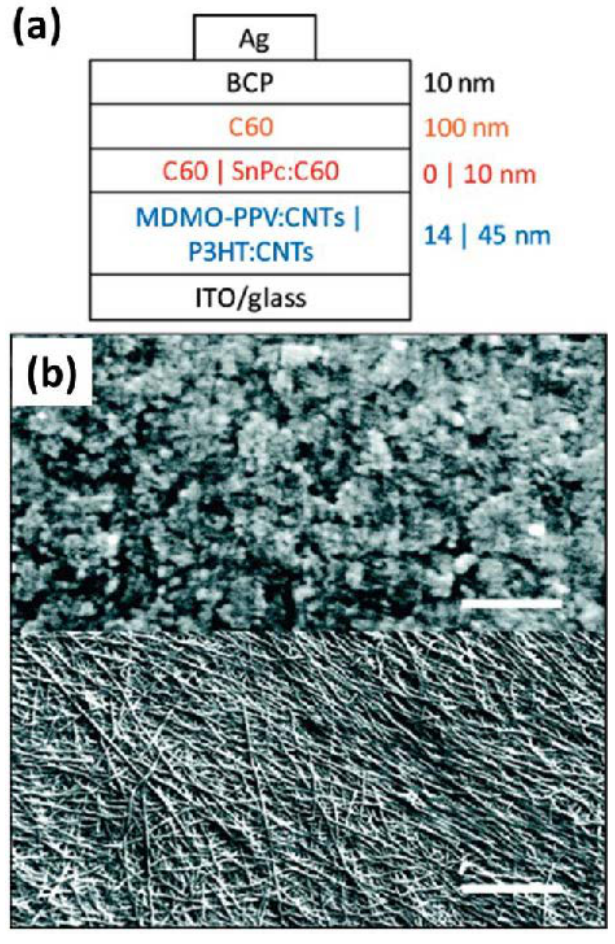
Figure 9: (a) Schematic of CNT/organic heterojunction and (b) Film morphology. Figures with reprint permission from: (a) and (b) Ref. [196] ©2009 American Chemical